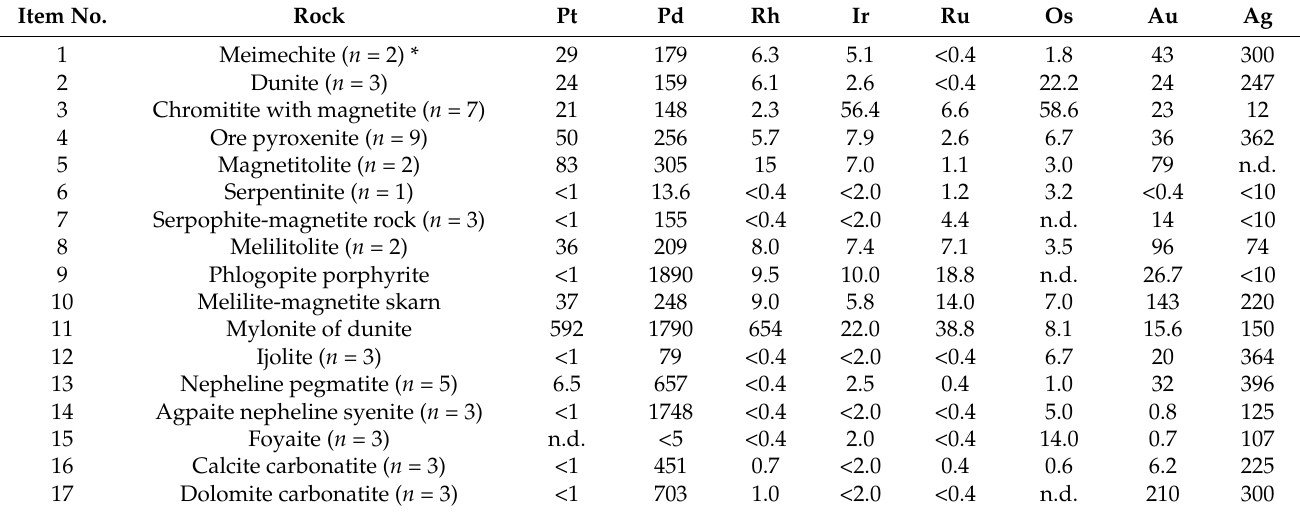
Table 3. Concentrations of precious metals in the rocks of the Guli intrusion, ppb.